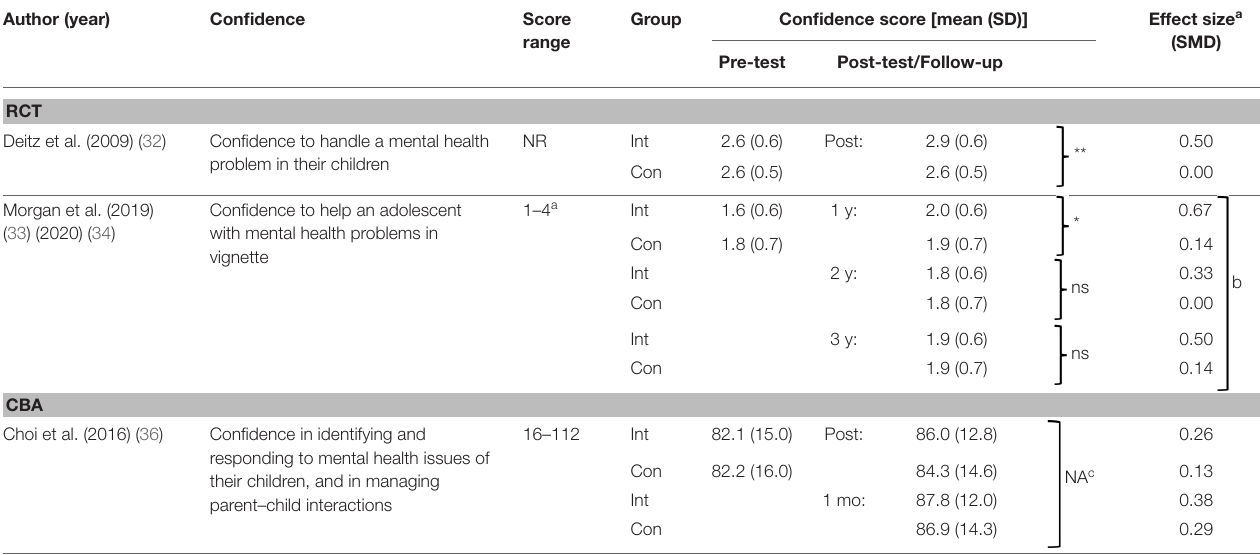
TABLE 6 | Effects on confidence in helping children with mental health problems. Author